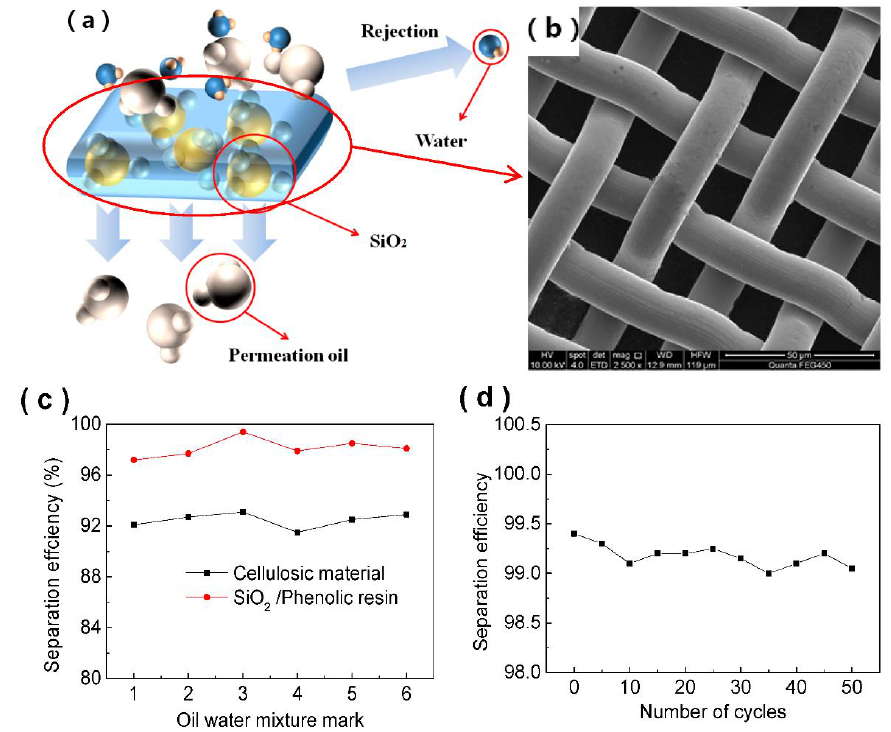
Figure 9. ( a ) Schematic of SiO 2 /phenolic resin for enhanced oily wastewater separation performance. ( b ) Schematic of SiO 2 /phenolic resin partial enlarged view. ( c ) Oil–water separation efficiency of different oils. Oil–water mixture mark: 1, vegetable oil; 2, methylbenzen; 3, n-hexane; 4, carbon